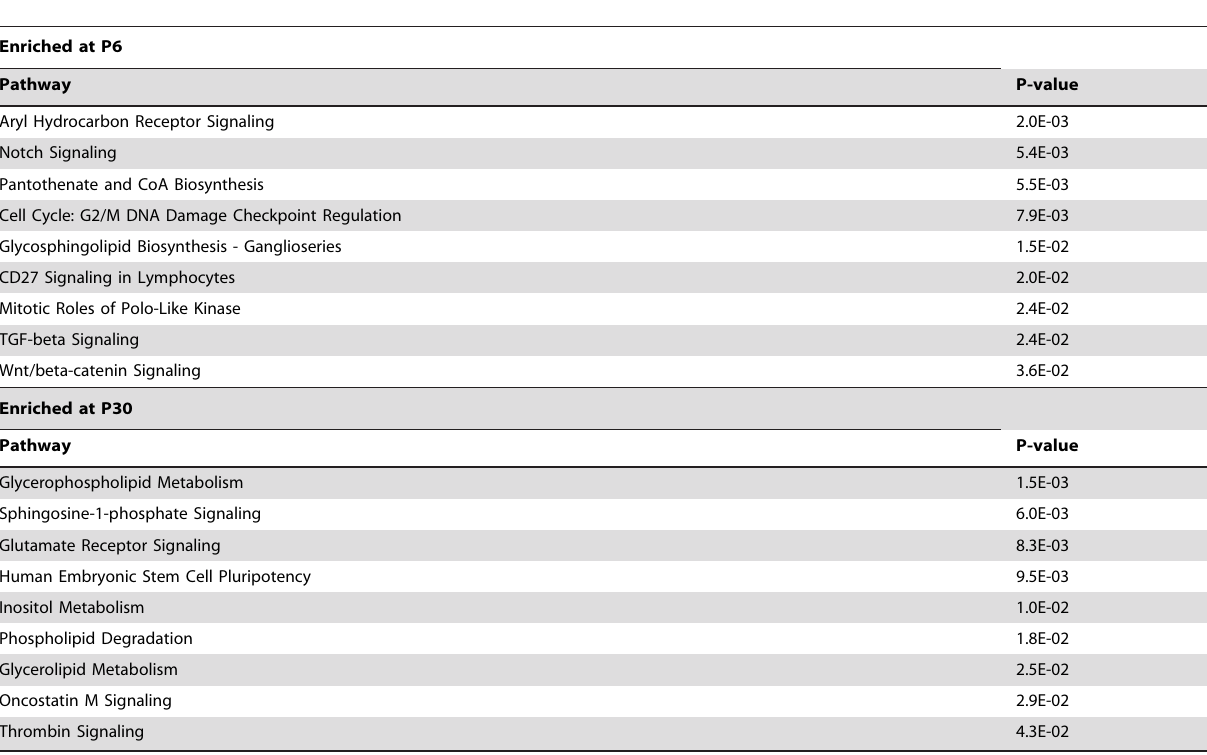
Table 6. Signaling and metabolic pathways enriched in Bergmann glia.